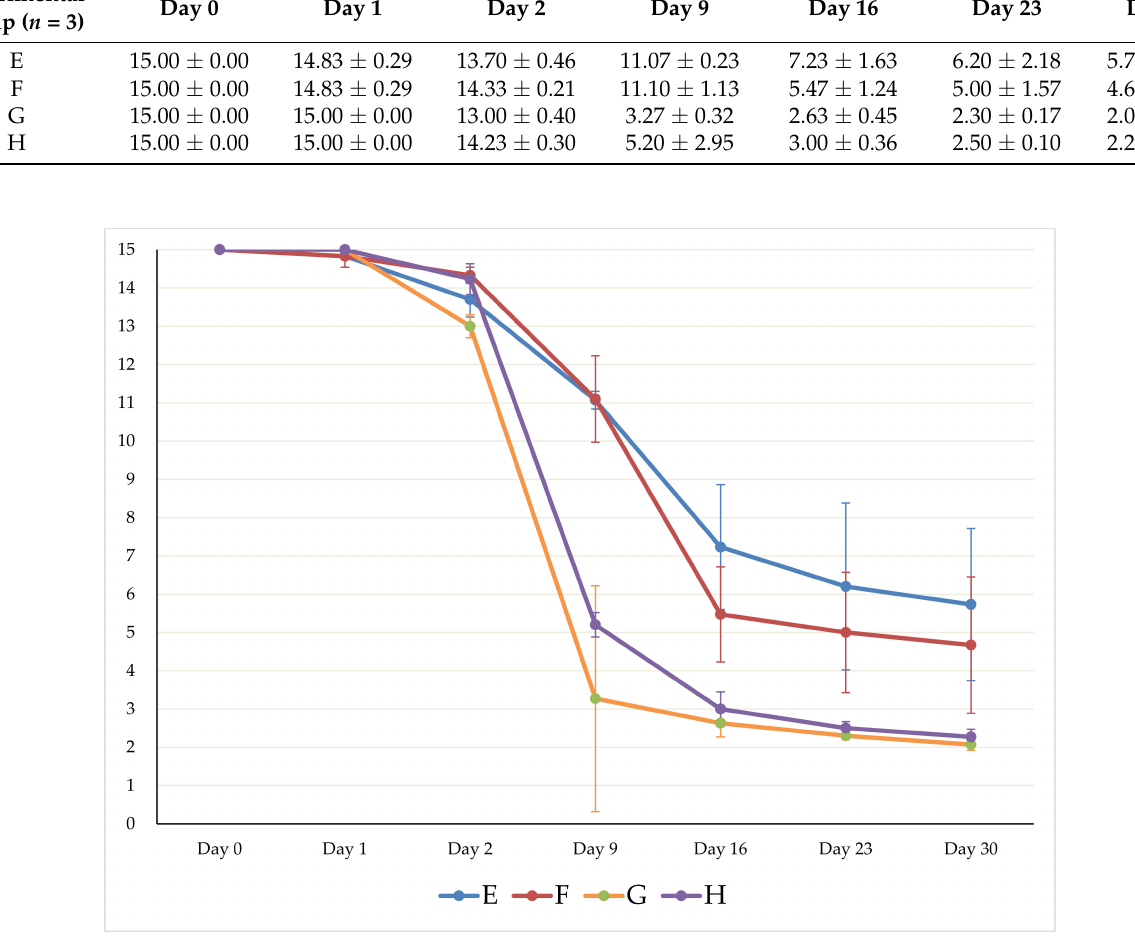
Figure 3. Graphical evaluation of the contraction assay with respect to the length shortening according to Table 2. Experimental group E: TLC with spider silk and 5.0 × 10 5 ASC. Experimental group F: TLC without spider silk and with 5.0 × 10 5 ASC. Experimental group G: TLC with spider silk and 5.0 × 10 6 ASC. Experimental group H: Construct without spider silk and with 5.0 × 10 6 ASC. All measurements were made as triplicate ( n = 3) and are graphically shown as mean ± standard